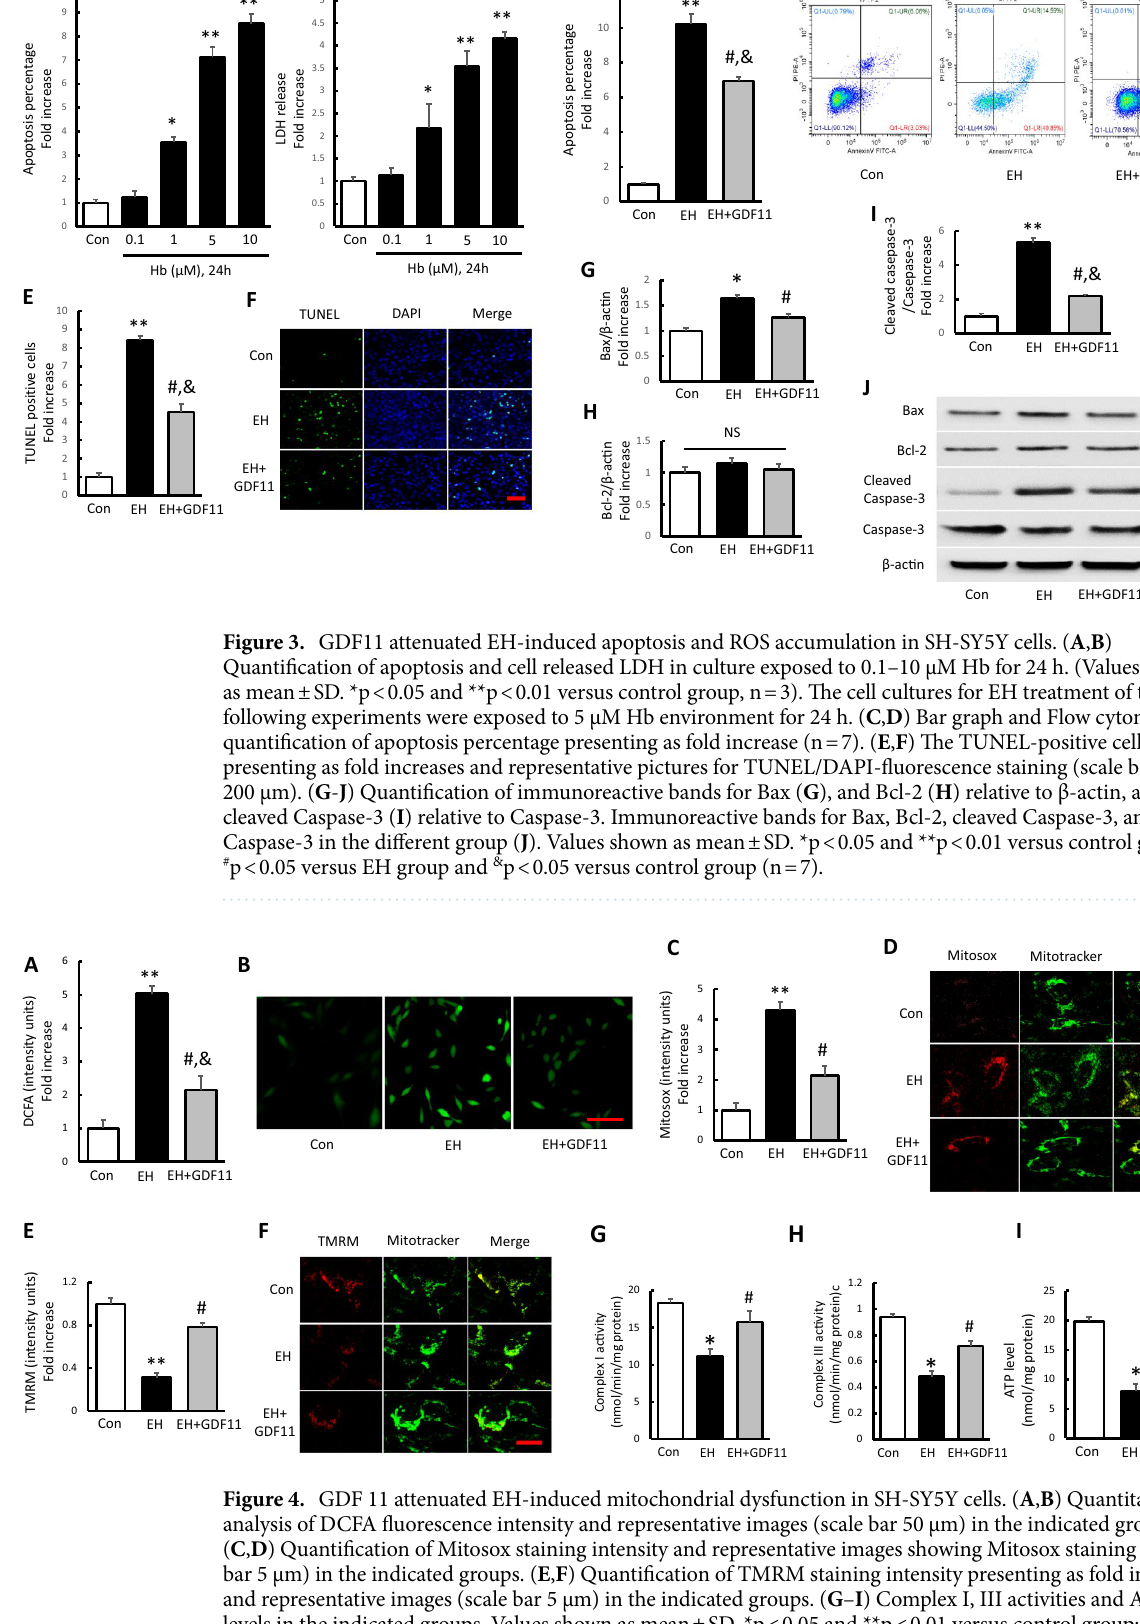
Figure 4. GDF 11 attenuated EH-induced mitochondrial dysfunction in SH-SY5Y cells. ( A , B ) Quantitative analysis of DCFA fluorescence intensity and representative images (scale bar 50 μm) in the indicated groups. ( C , D ) Quantification of Mitosox staining intensity and representative images showing Mitosox staining (scale bar 5 μm) in the indicated groups. ( E , F ) Quantification of TMRM staining intensity presenting as fold increase and representative images (scale bar 5 μm) in the indicated groups. ( G – I ) Complex I, III activities and ATP levels in the indicated groups. Values shown as mean ± SD. *p < 0.05 and **p < 0.01 versus control group; # p < 0.05 versus EH group and & p < 0.05 versus control group (n =